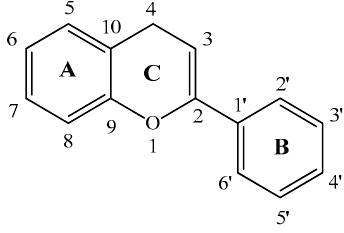
Figure 1. The 15-carbon skeleton of